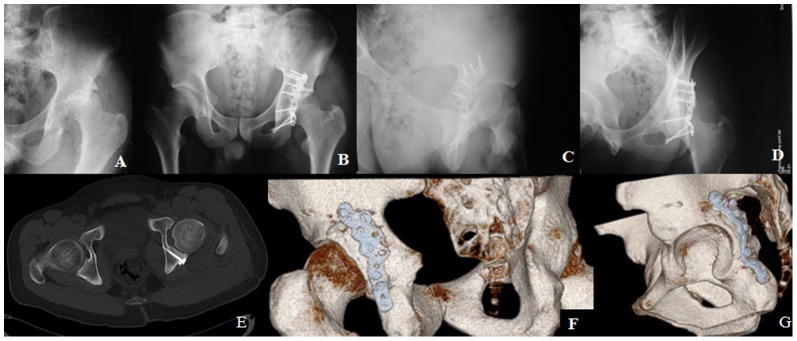
Emergency room radiograph of a 38-year-old man with a posterior wall fracture with posterior dislocation of the femoral head (A).The postoperative radiograph (B, C, D) and CT cut (E) demonstrate the extra-articular screw placement, and the VRT image shows a safe screw insertion into the posterior wall without violation into the joint (F,G).